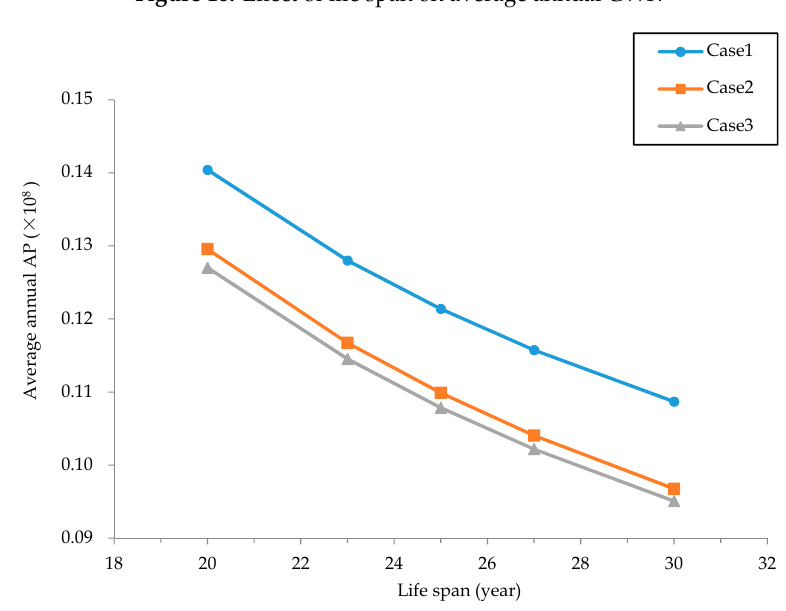
Figure 10. Effect of life span on average annual GWP .